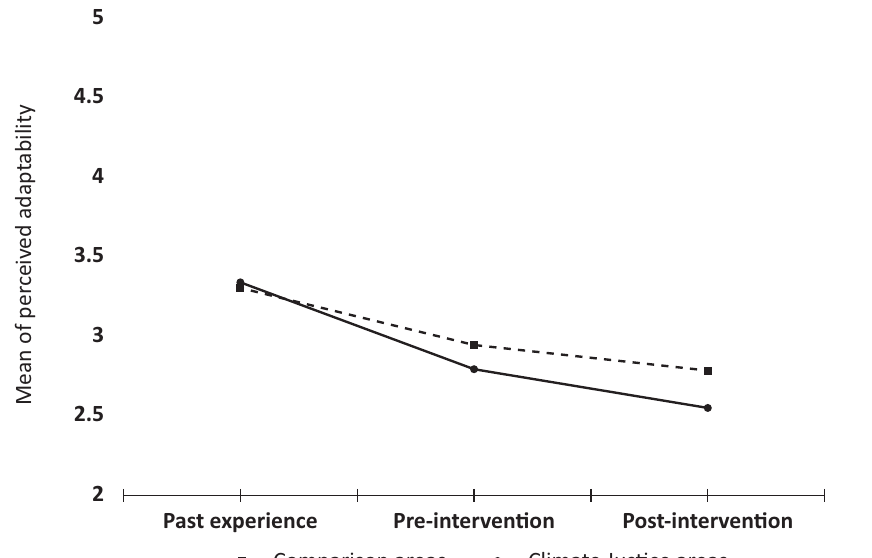
Figure 5. The effects of Climate Justice mapping intervention and group on participants’ ratings of perceived preparedness for future extreme